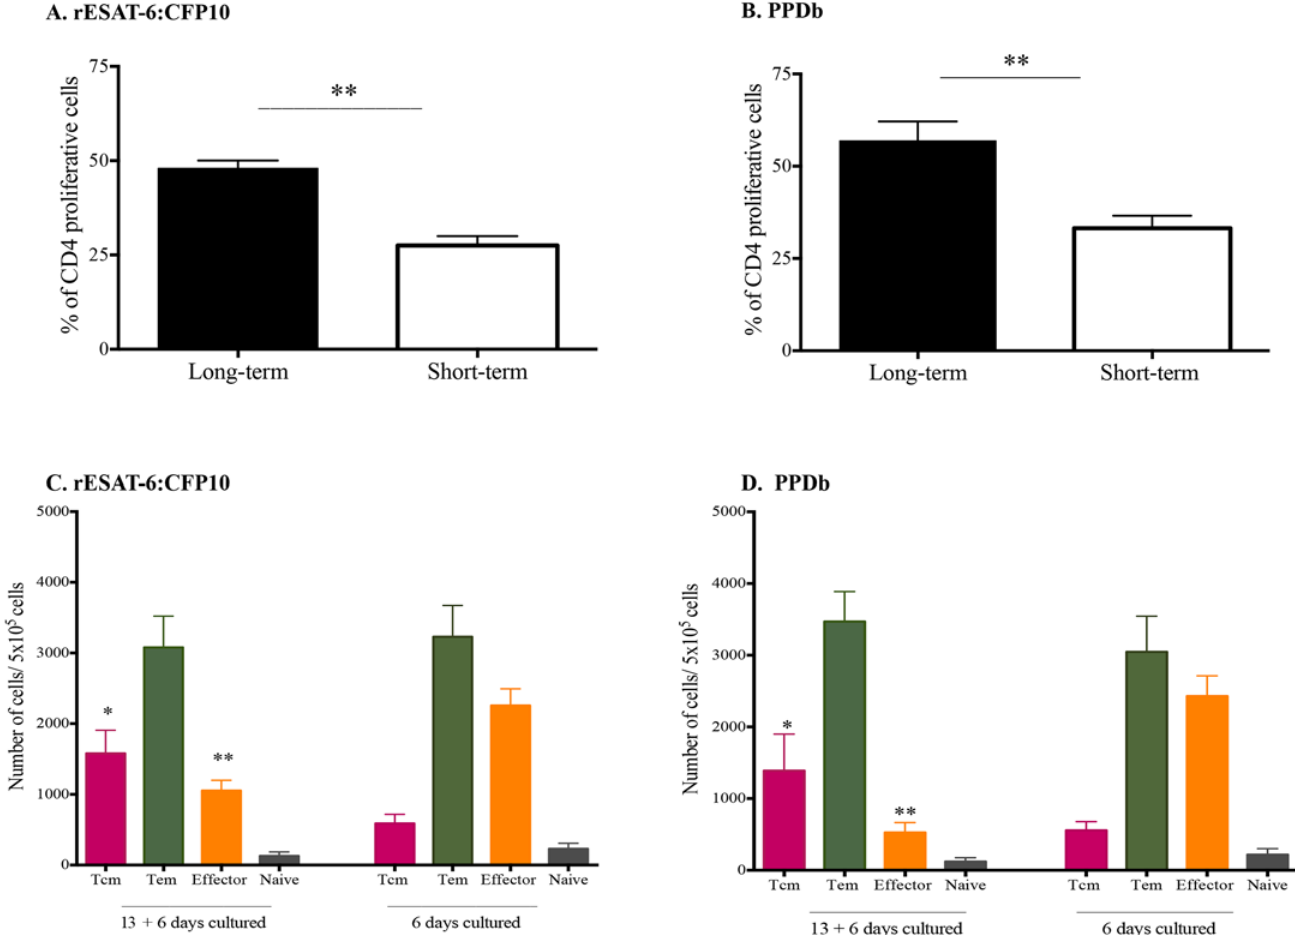
Fig 6. Long-term cultured cells have higher proliferative responses than short-term cells. Long-term and short-term cultured PBMCs were analyzed ~ 7 weeks after aerosol challenge with virulent M . bovis . Long-term cells consist of PBMC from M . bovis aerosol infected cattle cultured in the presence of rAg85A, rTB10.4, rESAT-6:CFP10 and PPDb for 13 days and then CellTrace violet-stained and re-stimulated with either rESAT-6:CFP10, PPDb or medium in the presence of fresh autologous adherent cells for an additional six days. Short-term cells consist of CellTrace violet-stained PBMC from M . bovis aerosol infected cattle cultured for six days in the presence of either rESAT-6:CFP10, PPDb or medium. The gating strategy was performed in accordance with procedures described in Fig 2A for single cells, and as shown in S3 Fig for lymphocytes, and CD4 + cells. (A) Percentages of CD4 + cells proliferating